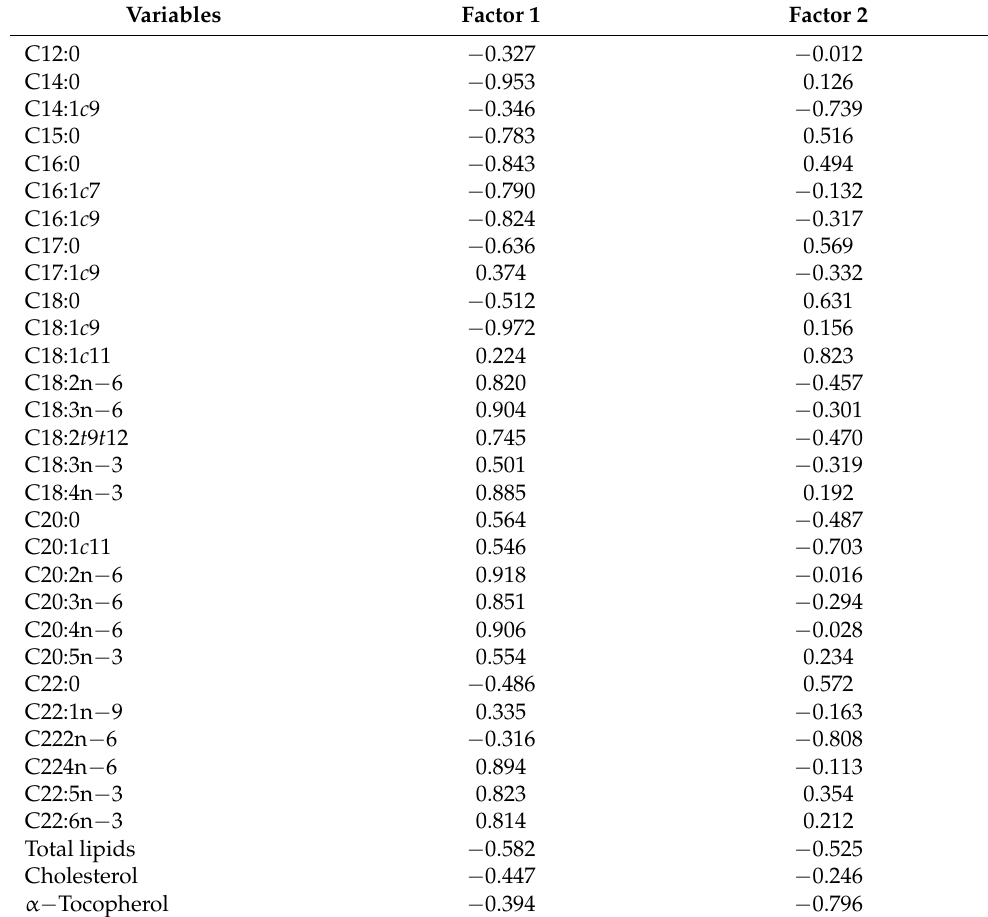
Figure 1. Principal component analysis of chemical composition variables of broiler breast meat: ( a ) loading plot of first and second principal factors of analysed data; ( b ) component score vectors. Experimental diets: control, maize–soybean diet; UL, control diet with 15% U. lactuca ; ULC, control diet with 15% U. lactuca and 0.005% commercial enzyme mixture; ULE, control diet with 15% U. lactuca and 0.01% recombinant ulvan lyase. Table 8. Loadings obtained with the first two principal components of breast meat